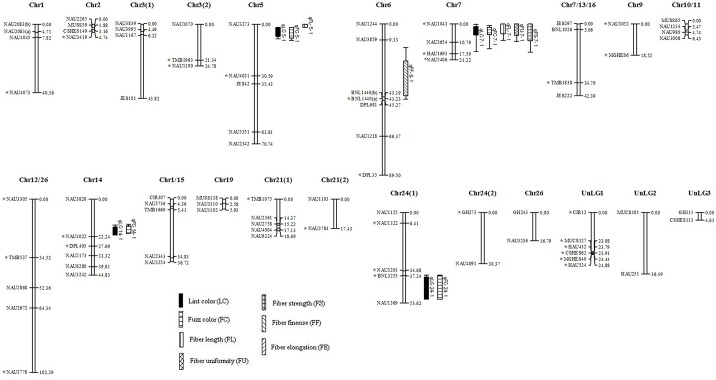
Linkage map from RIL population of Zong128 × KuchuT94-4.Linkage groups that could not be assigned to a chromosome were given the preliminary names UnLG1 –UnLG5. Bars and lines on the right-hand side of the linkage groups show the QTL likelihood intervals. Map distances in centimorgans (cM) are indicated on the left-hand side of the linkage groups. LC, lint color; FC, fuzz color; FL, fiber length; FU, fiber uniformity; FF, micronaire; FE, fiber elongation; FS, fiber strength; *Indicates distorted markers.